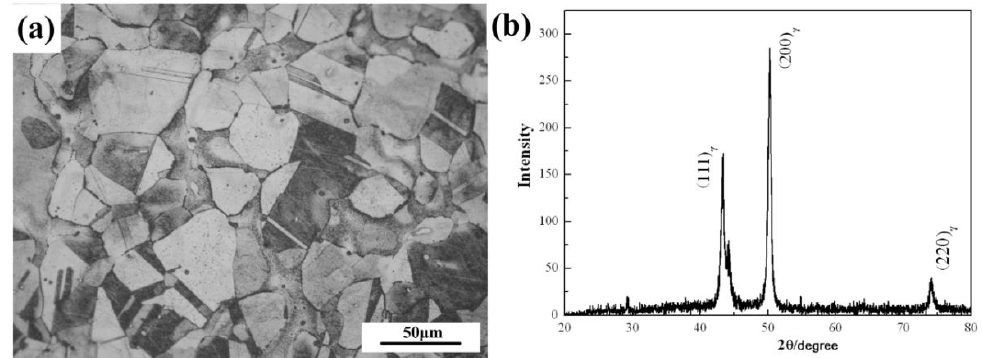
Figure 3. Optical micrograph and X-ray diffraction patterns of the sample in the solution state.